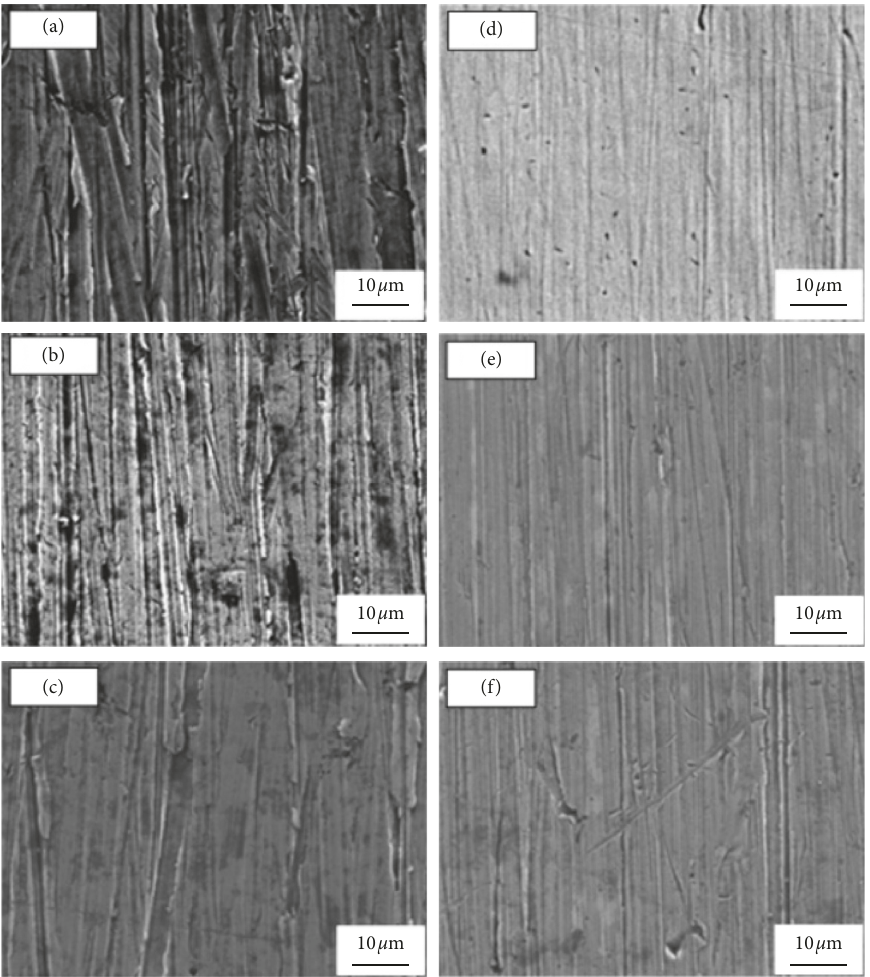
Figure 10: Wear morphology of Inconel 617 alloy substrate and cladding at different temperatures: (a) 200 ° C, (b) 600 ° C, and (c) 1000 ° C. Cladding at (d) 200 ° C, (e) 600 ° C, and (f) 1000 °